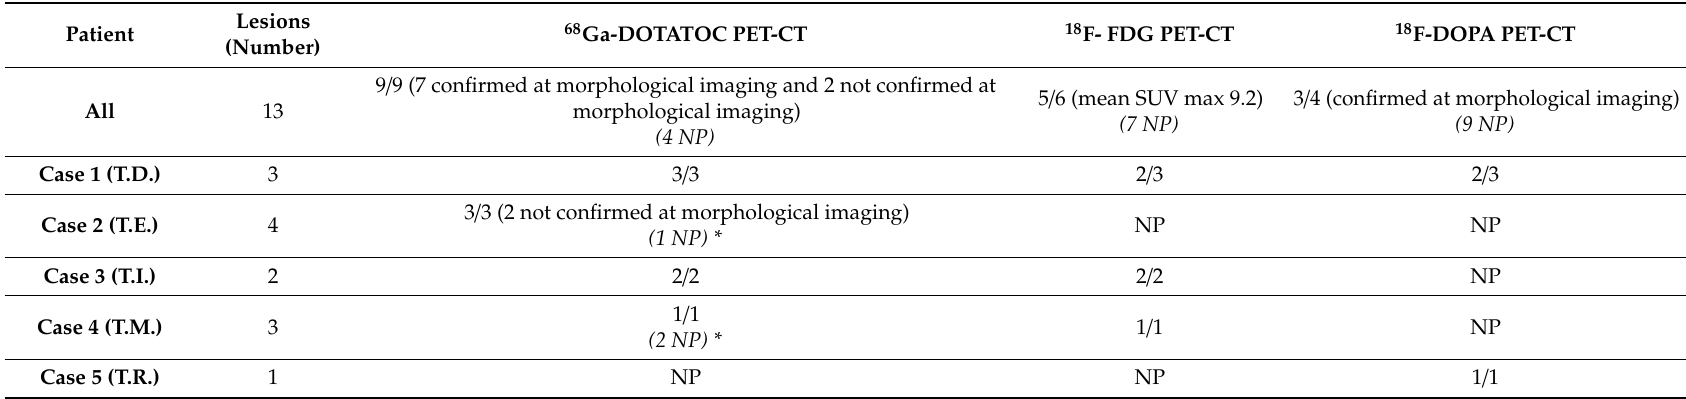
Table 2. Diagnostic performance of 68Ga-DOTATOC PET-CT, 18F- FDG PET-CT and 18F-DOPA PET-CT. Abbreviations: NP = not performed; PET = positron emission tomography; CT = computed tomography; DOTATOC = 1,4,7,10-tetraazacyclododecane-1,4,7,10-tetraacetic acid tyr3- Octreotide; FDG =